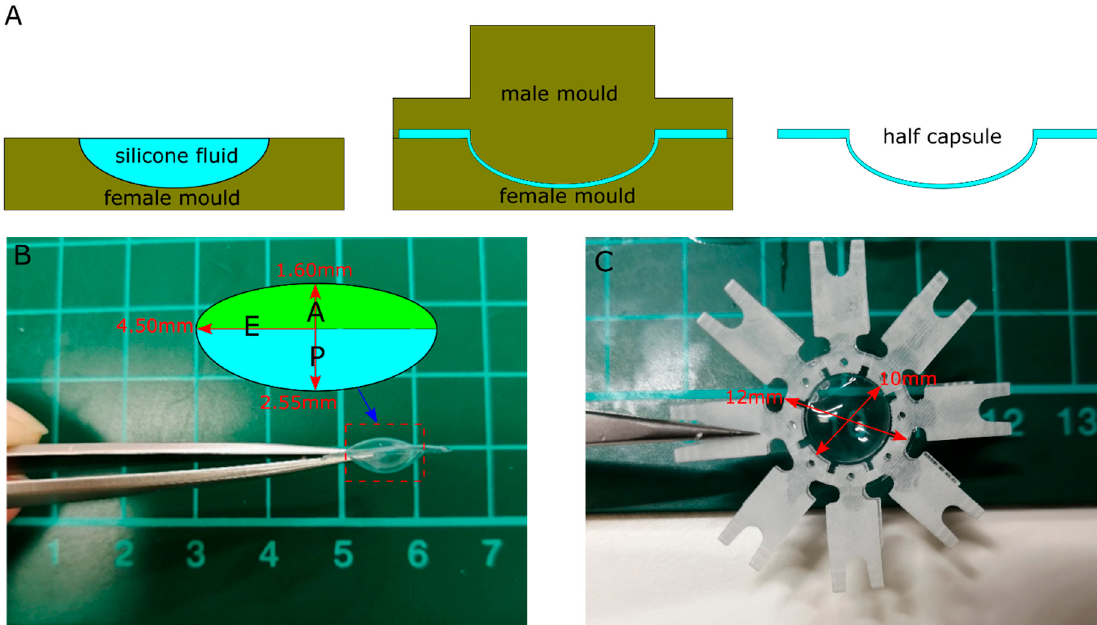
Figure 2. Preparation of artificial lens capsule (ALC): ( A ) moulding process; ( B ) assembled capsule; ( C ) with support structure.